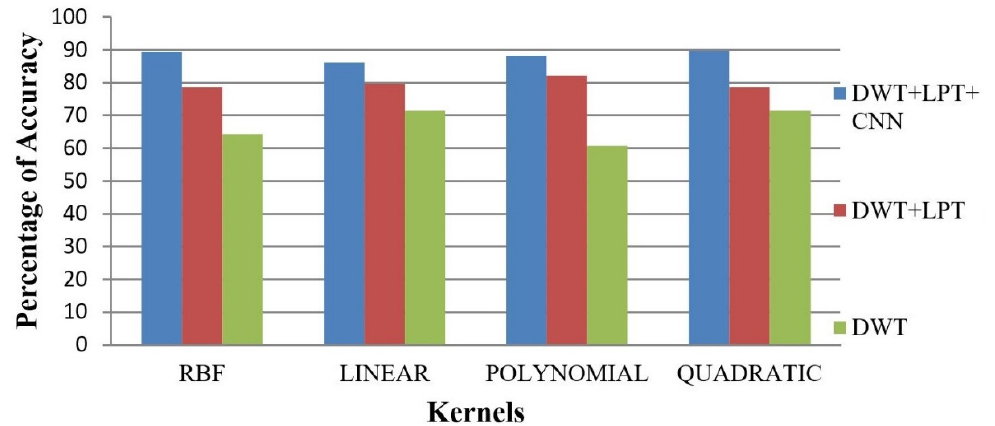
Figure 9. Average Accuracy for Tumor Detection of Distorted/Simulated image.